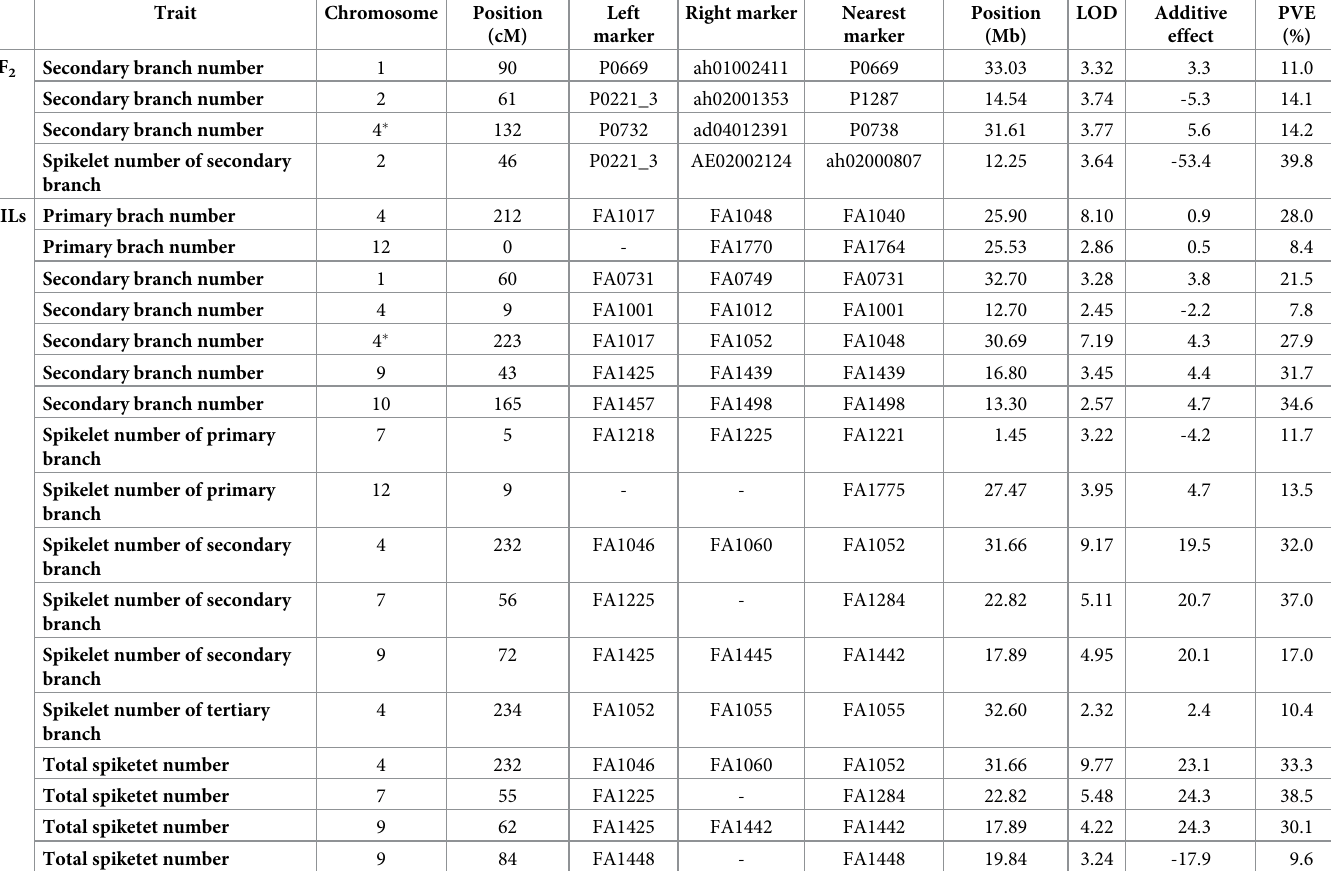
Table 5. Summary of QTLs detected in the F 2 and recombinant inbred lines from a cross between Monster Rice 1 and Takanari about rachis branching and spikelet number per